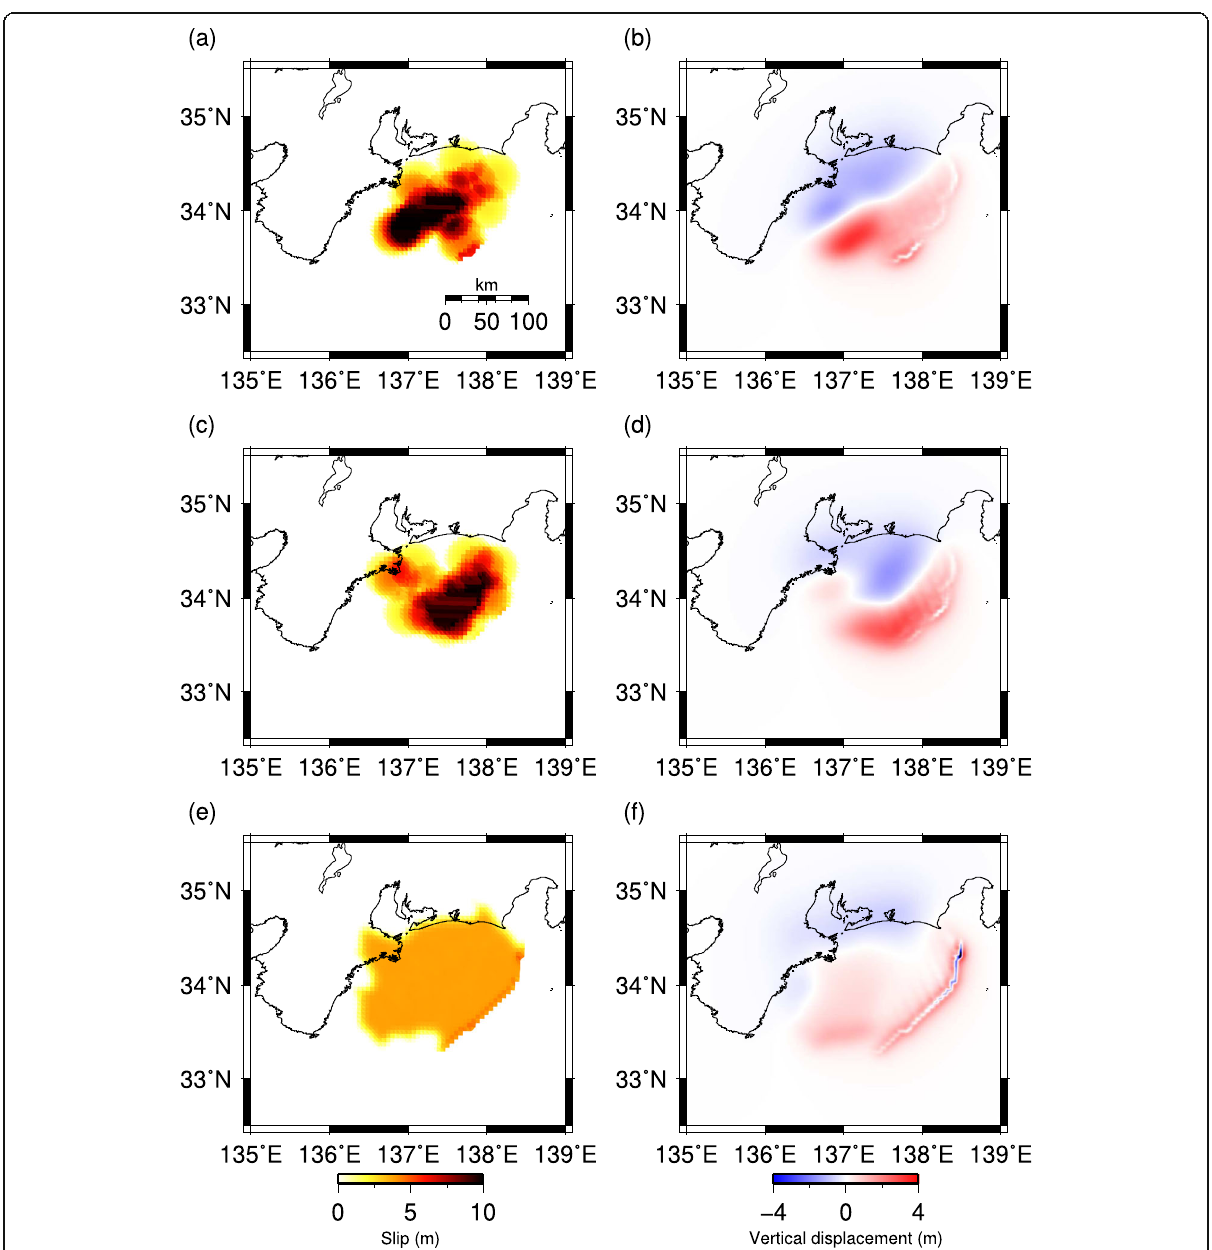
Fig. 8 Comparison of the slip distribution and the corresponding seafloor deformation. a , b The scenario that caused the largest tsunami amplitudes near the Shima Peninsula. c , d The scenario that caused the smallest tsunami amplitudes near the Shima Peninsula. e , f Uniform slip distribution on the earthquake